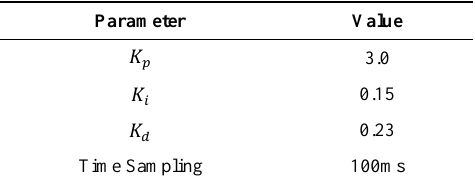
Table 5. PID Heading Tuning Results